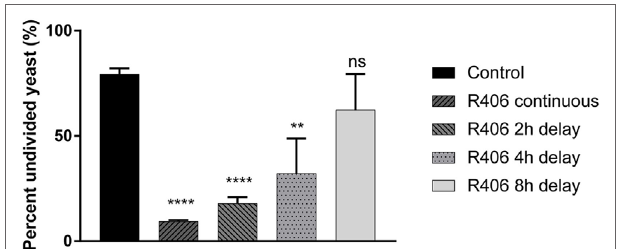
FigUre 4 | Spleen tyrosine kinase (Syk) is required at an early stage for macrophage control of Candida glabrata . Macrophages were treated with chemical Syk inhibitor, R406, prior to addition of C. glabrata for 2, 4, and 8 h after infection. All wells were lysed after 16 h of co-culture and the yeast retrieved and stained with ConA-AF647. Percent of parental CFSE-bright population was assessed via flow cytometry, with R406 treatments initiated